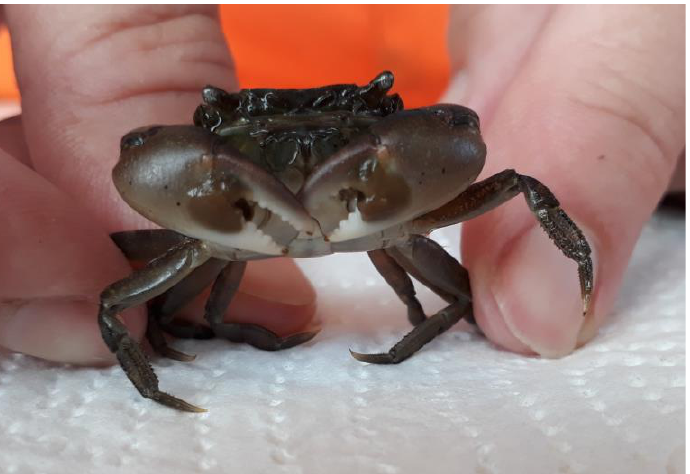
Figure 14. Male Hemigrapsus takanoi . Specimen from Dybsø Fjord, July 2018. Photo: M. and S. Mik- kelsen.